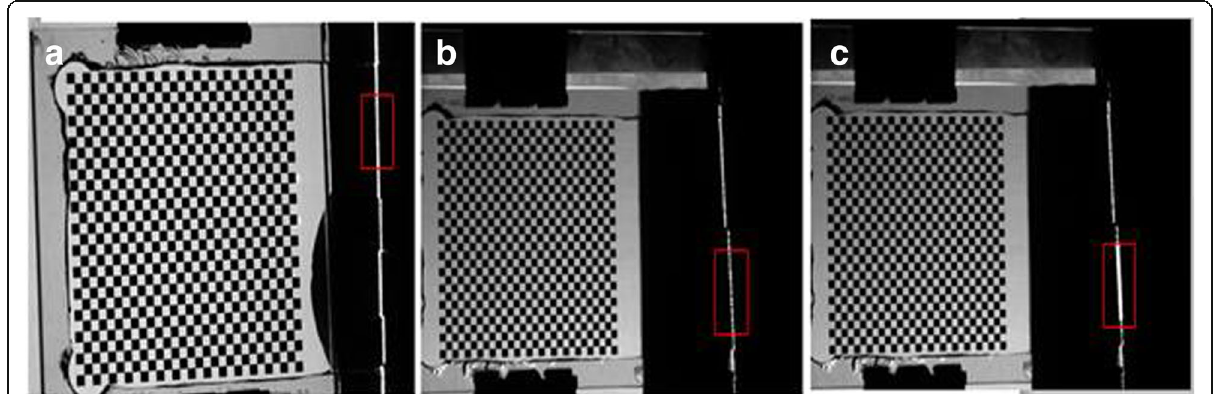
Fig. 14 The light stripe images before and after enhancement in 2 mm gauge block. a The template image b The image before enhancement c The image after enhancement